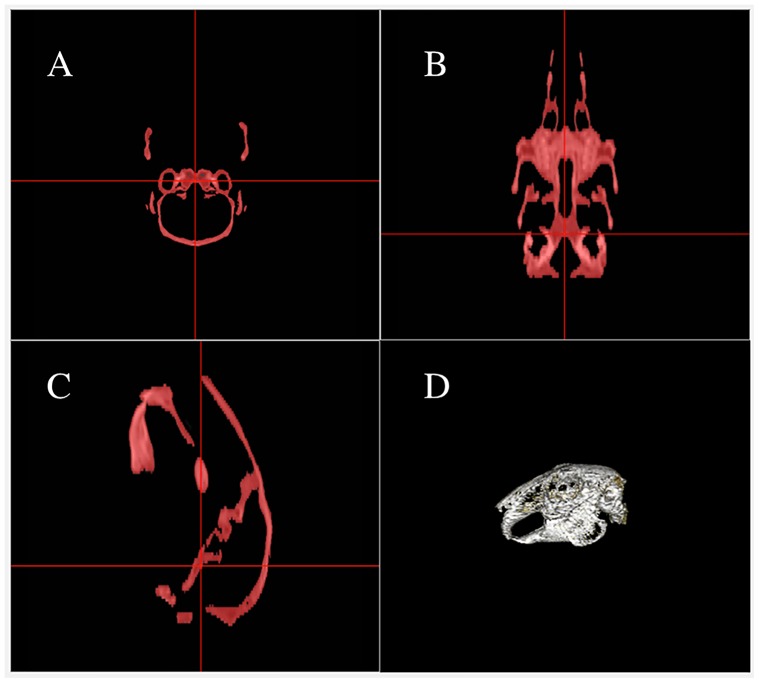
Multiplanar reconstruction view of the bone threshold process using a range of 0 Hounsfield units (HU) – max HU, following initial soft tissue removal.Images A, B and C are the transverse, dorsal and sagittal plane sample images, respectively. Image D is a 3-dimensional volume rendered image of the included bone.